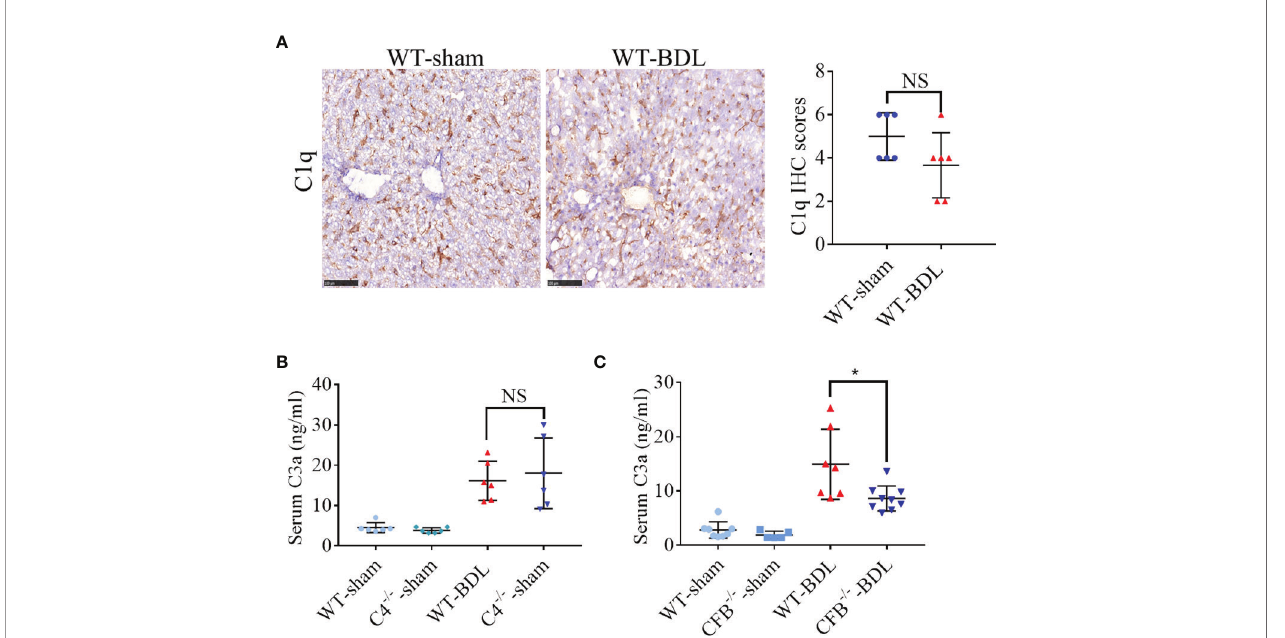
FIGURE 2 | Contribution of the alternative pathway to the over-activation of the complement system in mice with CLI. Wild-type mice and mice de fi cient in the genes encoding complement components C4 and Factor B were subjected to BDL or sham operations. The mice were sacri fi ced after 3 days and the samples were collected. (A) Immunostaining for C1q in fresh frozen liver sections (scale bar, 100 m m). (B, C) Serum C3a concentrations in mice de fi cient in genes encoding (B) C4 and (C) Factor B (n = 5 – 8 for each sham operated group; n = 6 – 9 for each BDL group). Results are expressed as mean ± SD. *p < 0.05; NS, not signi fi